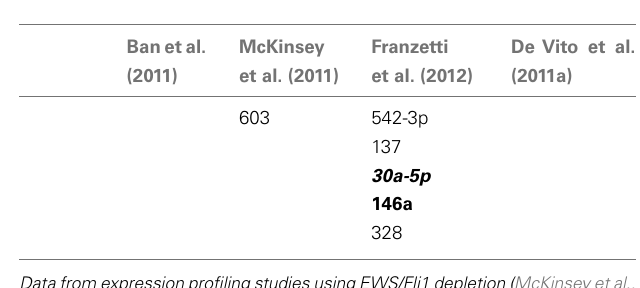
Table 1 |Alterations in miR expression as a function of EWS/Fli1 or/and presumed cell of origin in Ewing